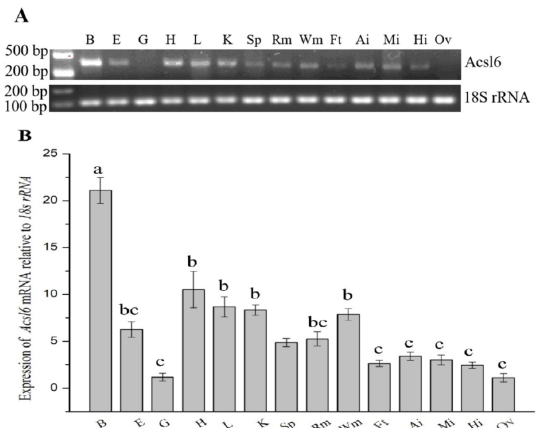
Figure 3. Semi-quantitative RT-PCR ( A ) and real-time quantitative PCR ( B ) analyses of acsl6 mRNA expression: Expression values were normalized to those of 18S rRNA. Data are means ± SEM ( n = 3). Bars not sharing a common letter indicated significant differences ( p < 0.05) as determined by one-way ANOVA followed by Tukey’s multiple comparison test. Abbreviations: B, brain; E, eye; G, gill; H, heart; L, liver; K, kidney; Sp, spleen; Rm, red muscle; Wm, white muscle; Ft, mesenteric fat; Ai, anterior intestine; Mi, middle intestine; Hi, hind intestine; and Ov, ovary.